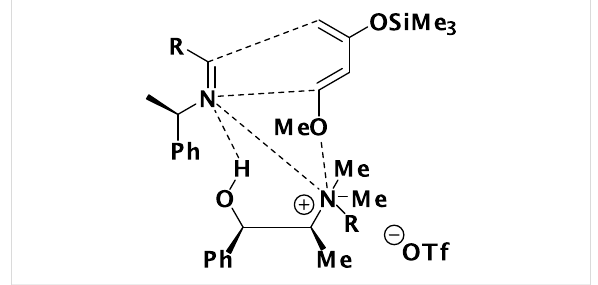
Figure 1: Possible interactions of substrates or intermediate of the aza-Diels-Alder reaction with the chiral cation of an IL containing a hydrogen-bond